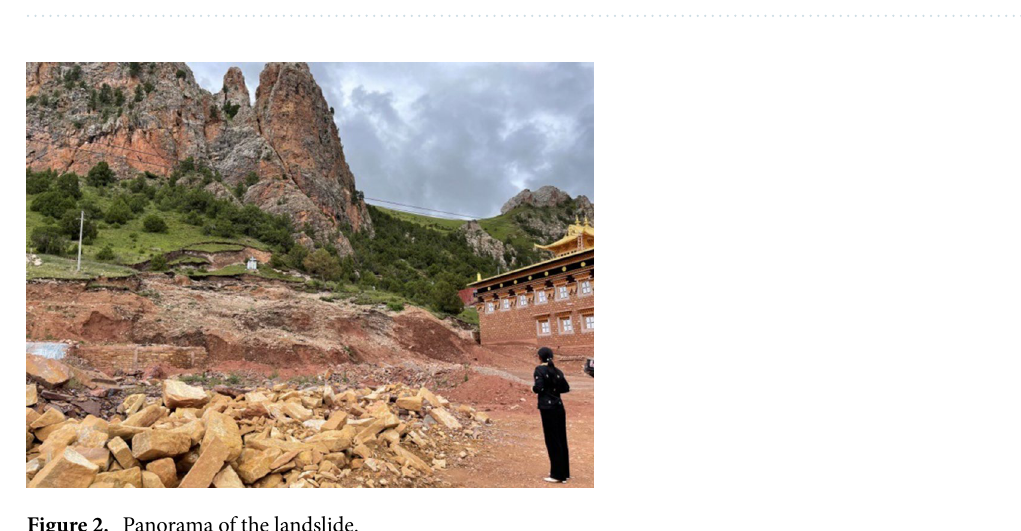
Figure 1. Aerial satellite image of the landslide (download using BIGEMAP GIS).